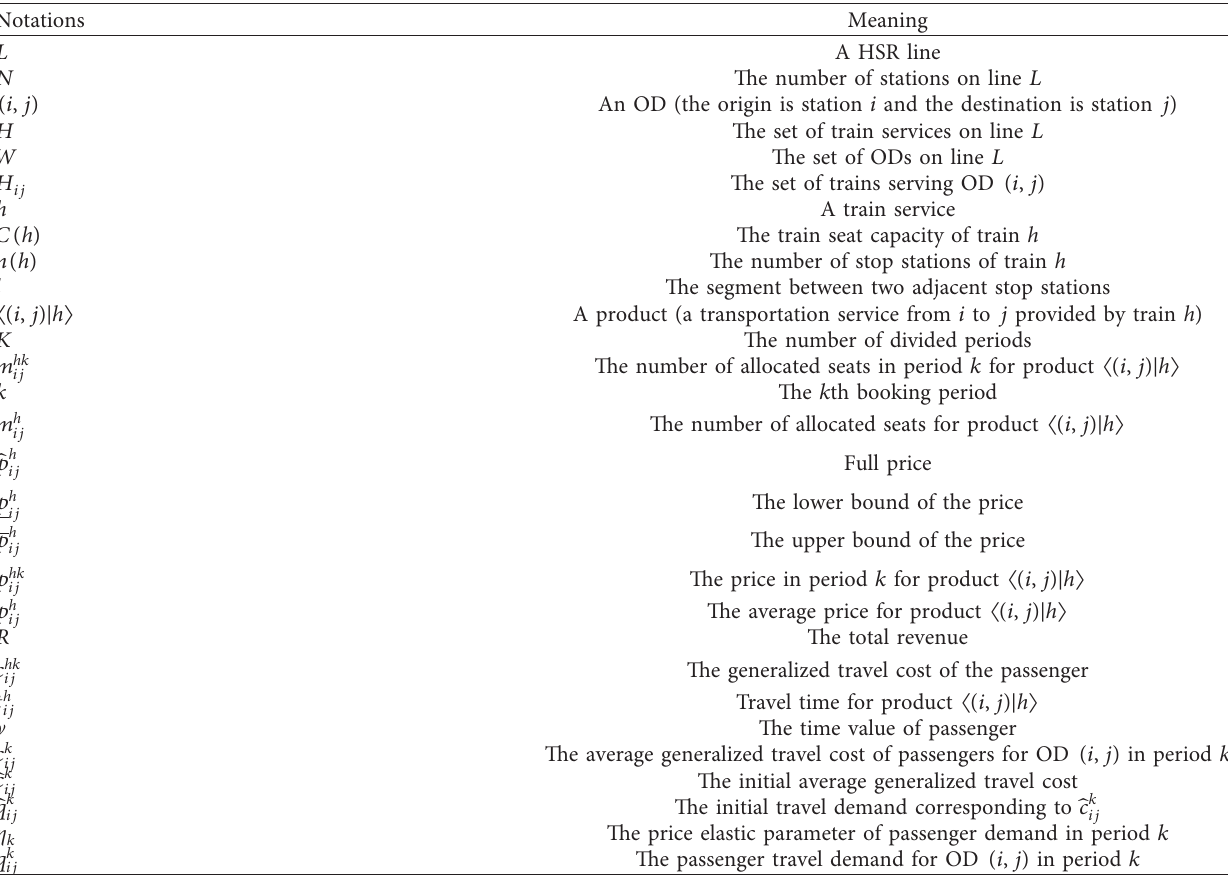
Table 2: Parameters and decision